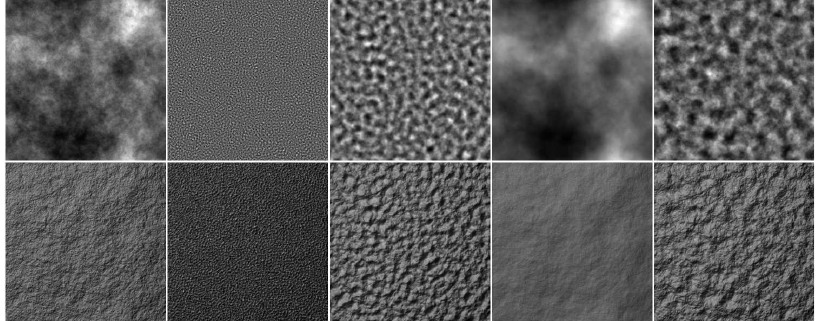
Figure 11. Textures generated with fractal models. First, row: height maps. Second row: relighting